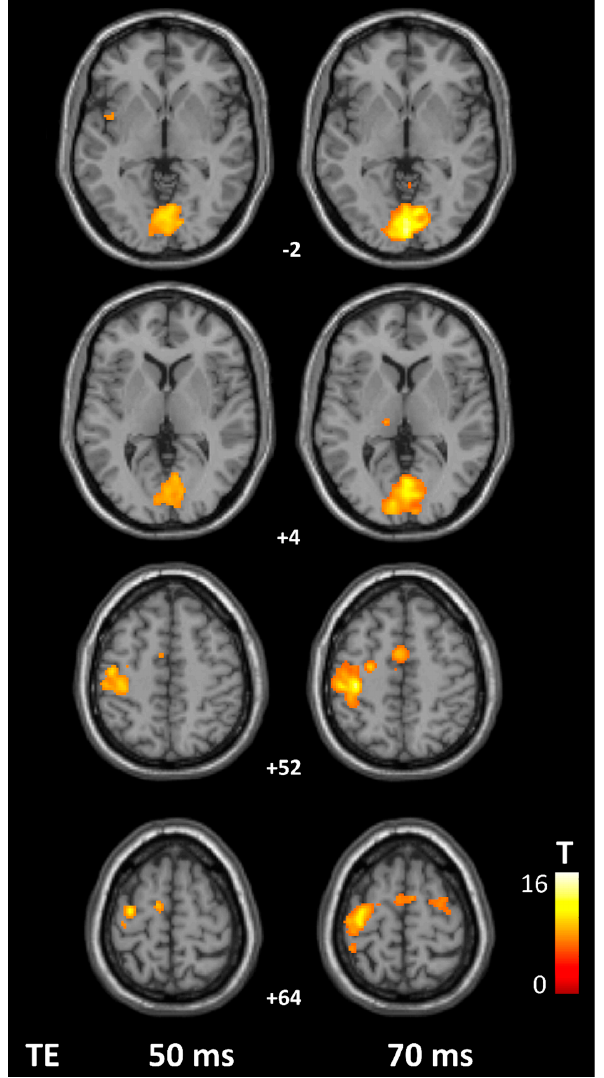
Figure 3. Group-level activation maps by TE condition, thresholded at p < 0.05 FWE. V2 activity appears primarily in the uppermost panel, V1 in the upper-middle panel (bilaterally), left MI, SI and bilateral SMA in the lower-middle panel, whereas left PMd activation is apparent in the lowest panel. Numbers represent z MNI coordinates (in mm).